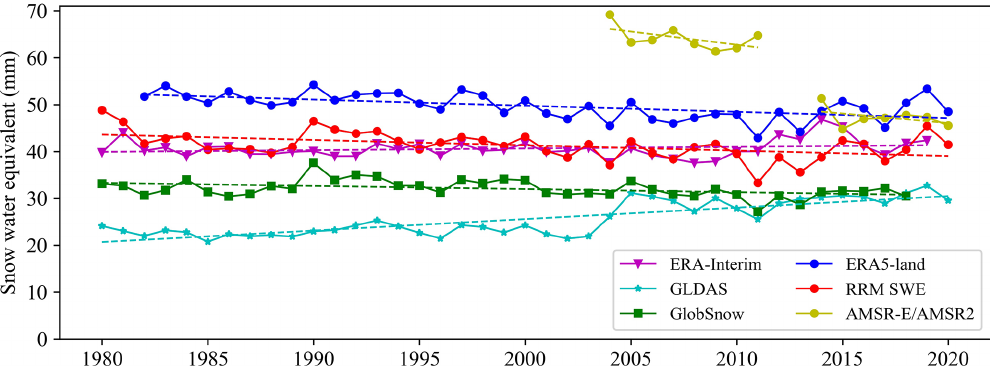
Figure 8. Annual variation tendency of the AMSR-E/AMSR2 SWE, ERA-Interim SWE, GLDAS SWE, GlobSnow SWE, ERA5-Land SWE, and RRM SWE products from 1979 to 2019 (the dotted line is the trend line calculated based on the Mann–Kendall